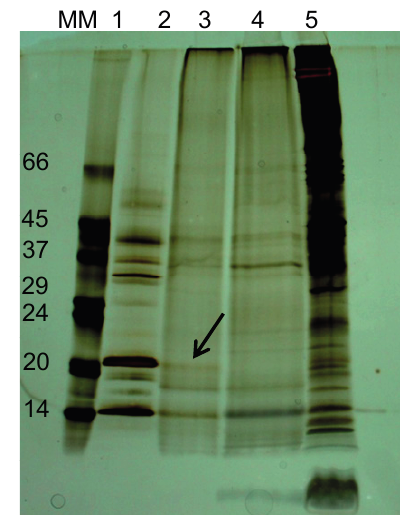
Effective elution of Blad from erythrocyte membranes was achieved with 0.4 M galactose (Figure 4). Binding of the 20 kDa polypeptide to the glycosylated receptors on erythrocyte membranes and the corresponding elution with 0.4 M galactose confirms the lectin nature of Blad. Figure 4. NR-SDS-PAGE electrophoretic profile of Blad elution with 0.4 M galactose (lane 2) from erythrocyte membranes, and comparison with the pure Blad-containing oligomer (lane 1). Galactose elution from a control membrane with no previous protein incubation is presented (lane 3). The final membrane (lane 4) represents the electrophoretic profile remaining in the membrane after Blad elution. Molecular masses of standards (MM) are indicated in kDa. Arrow points to the polypeptide bound to erythrocyte membranes. MM